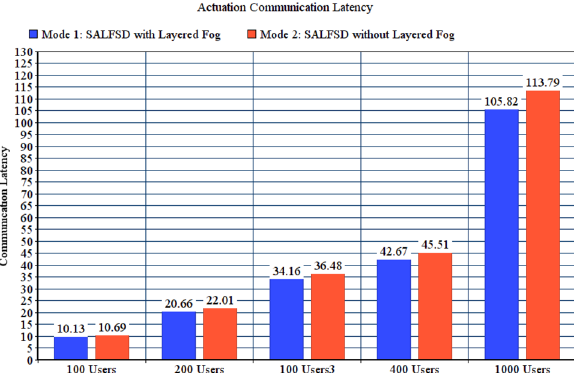
Figure 11. Actuation computation latency, SALFSD with and without layered